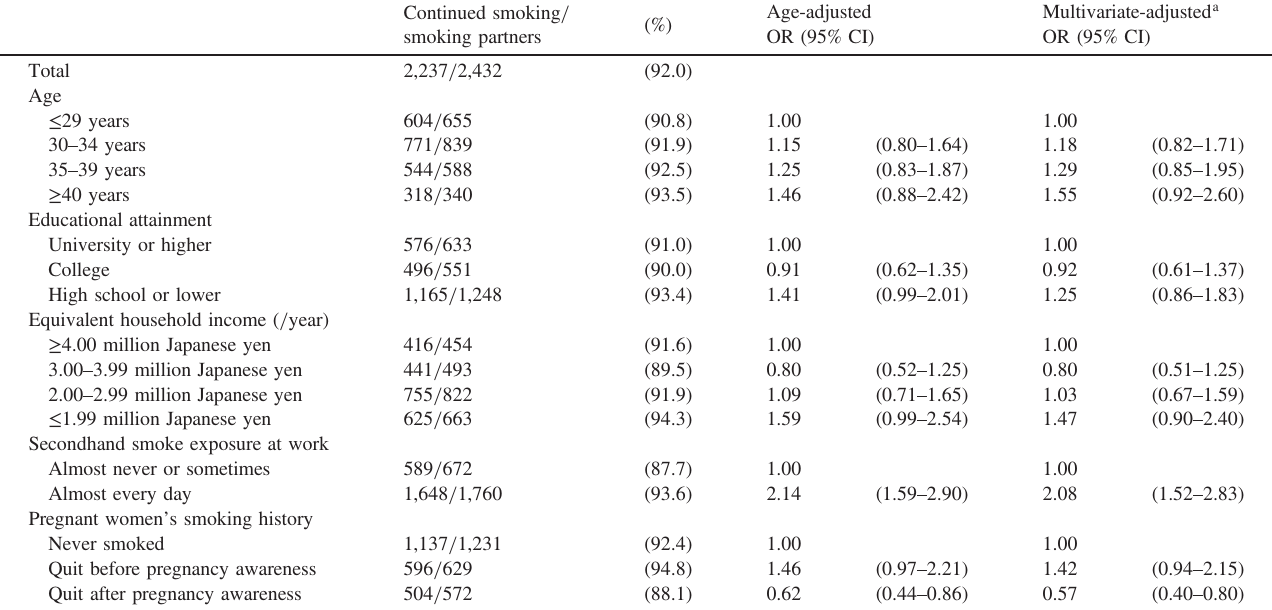
Table 2. Prevalence, odds ratios (ORs) and 95% con fi dence intervals (CIs) for continued smoking among smoking partners when becoming aware of the